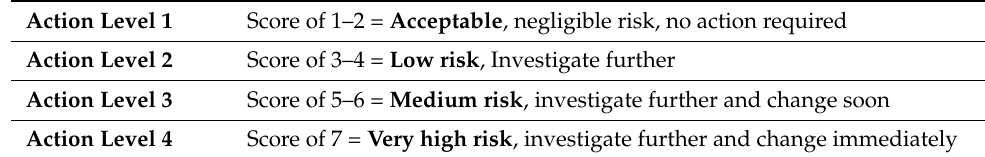
Table 2. RULA action level ergonomics risk assessments and guideline. Action Level 1 Score of 1–2 = Acceptable , negligible risk, no action required Score of 3–4 = Low risk , Investigate further Score of 5–6 = Medium risk , investigate further and change soon Score of 7 = Very high risk , investigate further and change